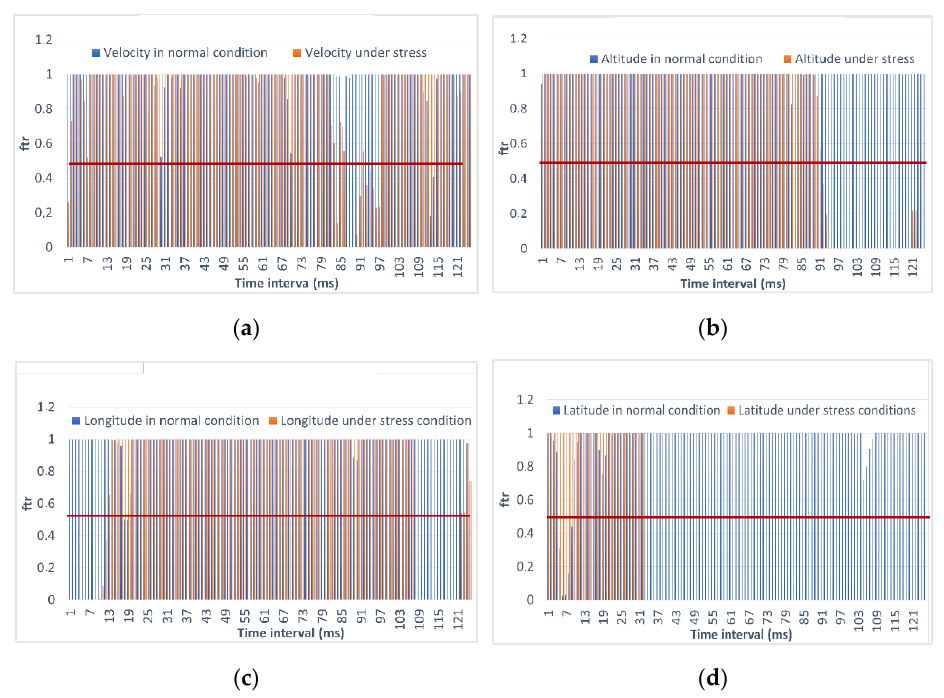
Figure 11. Evaluation of Metric 1 during flight in mission mode under normal and stress conditions for indicators of ( a ) flight speed; ( b ) flight altitude; ( c ) flight latitude; ( d ) flight longitude.